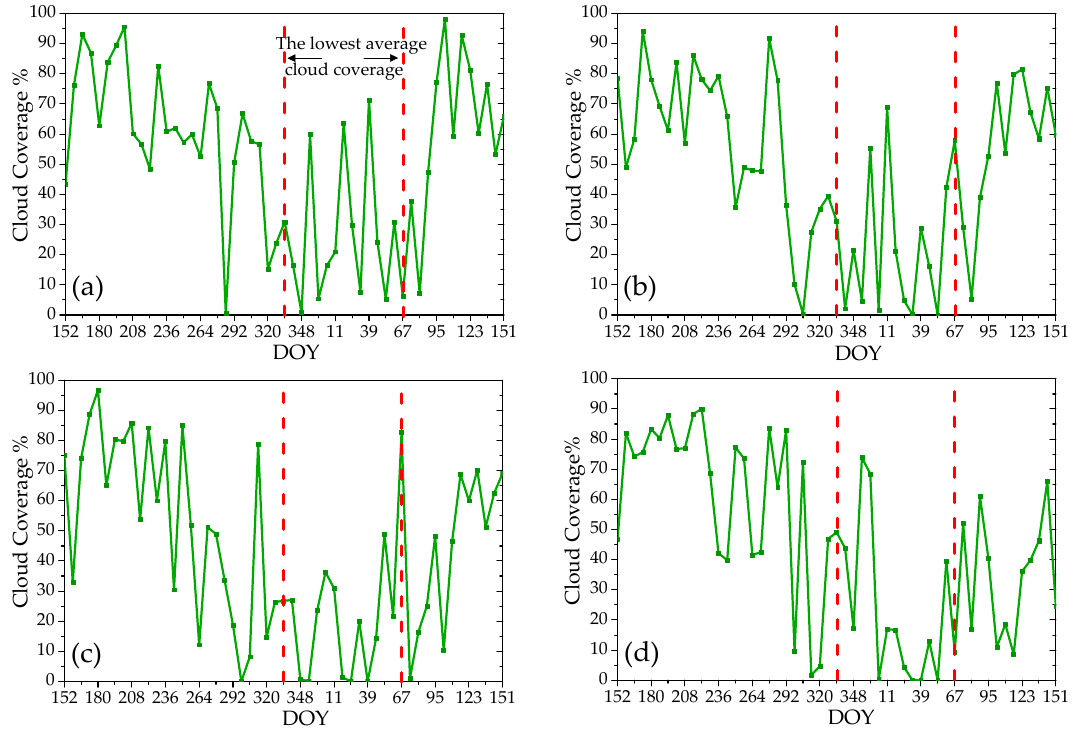
Figure 3. The average cloud coverage was calculated over each 7 day period between June and June of the year: ( a ) 2000; ( b ) 2005; ( c ) 2010; ( d ) 2015.